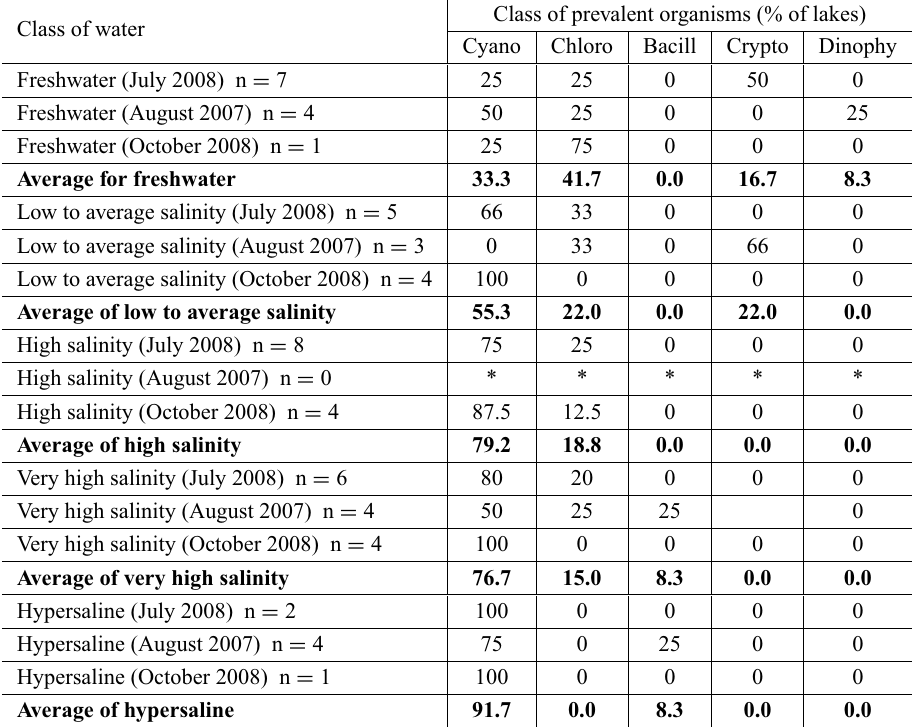
Distribution of the percentage of classes of prevalent phytoplankton organisms in relation to the total number of phytoplanktonic classes described for the groups of lakes classified according to Table I. Cyanobacteria = Cyano; Chlorophyceae = Chloro; Bacillariophyceae = Bacill; Cryptophyceae = Crypto; Dinophyceae =